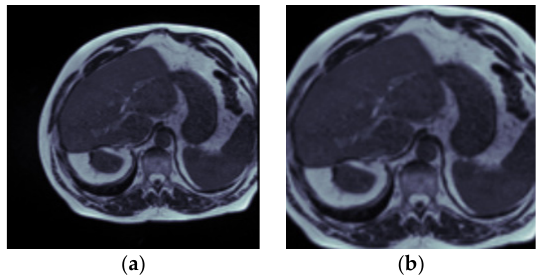
Figure 3. Dataset Resizing: ( a ) Input Image & ( b ) Resized Image.